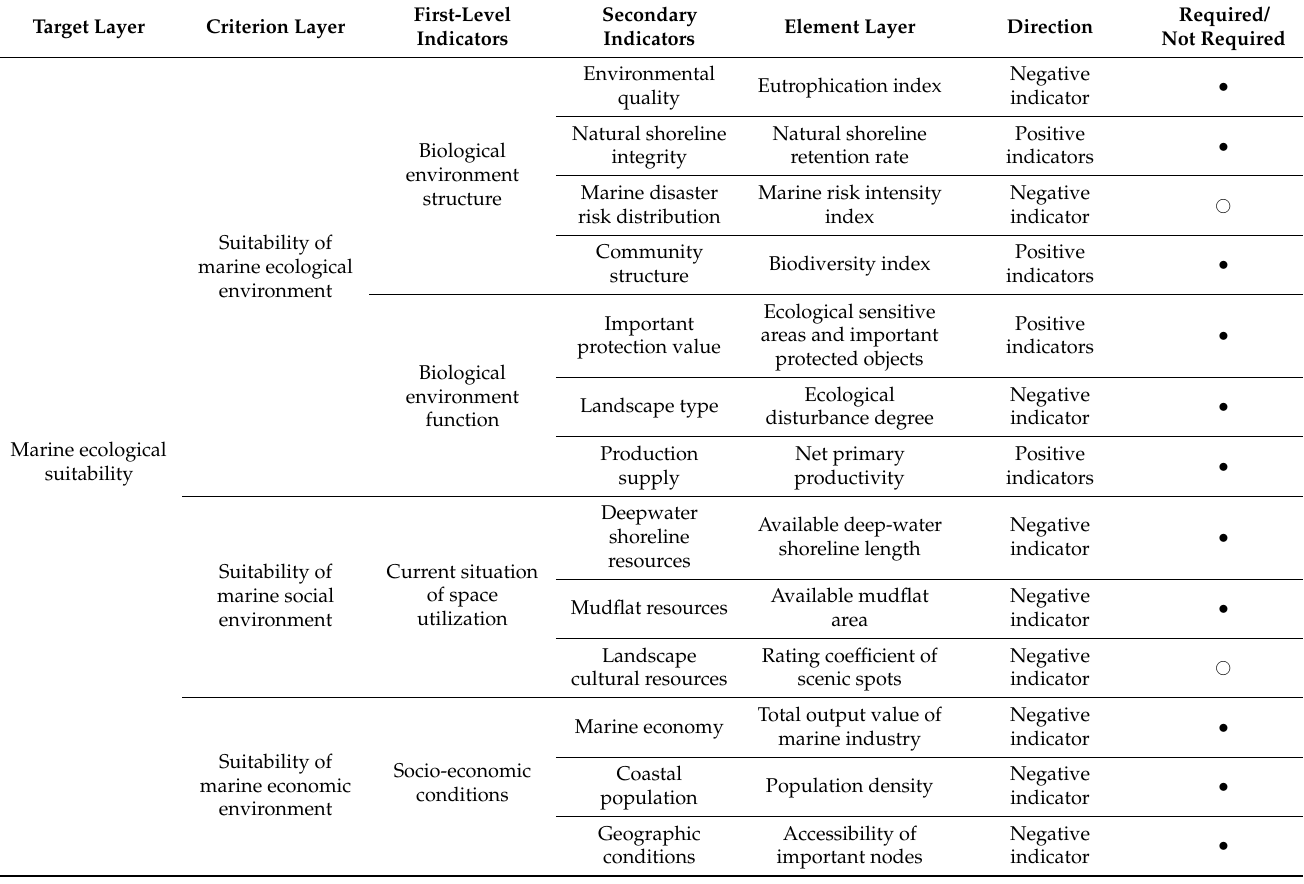
Table 1. Evaluation index system of marine ecological